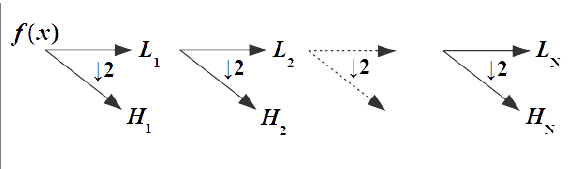
Figure 1. DWT diagram according to the Mallat algorithm (the horizontal vector corresponds to low, the diagonal to high-pass